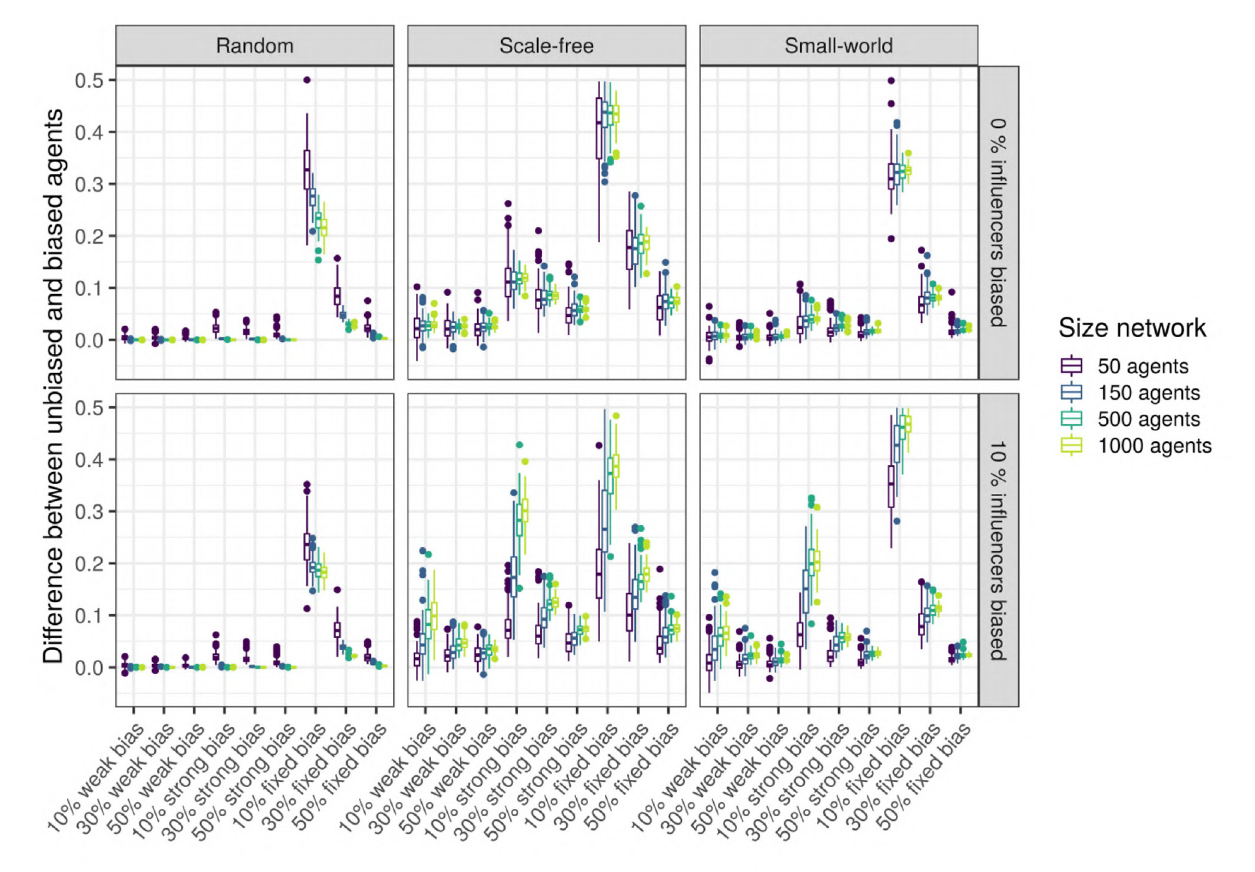
FIGURE 10 | Top row: The difference between the languages of the unbiased and the biased agents after 5,000 iterations, function of network type and influencers biased (panels), size (color), and bias frequency and strength (horizontal axis). We used SAM agents, there is no enrichment of biased agents among the top influencers, and agents were exposed to an initial language.